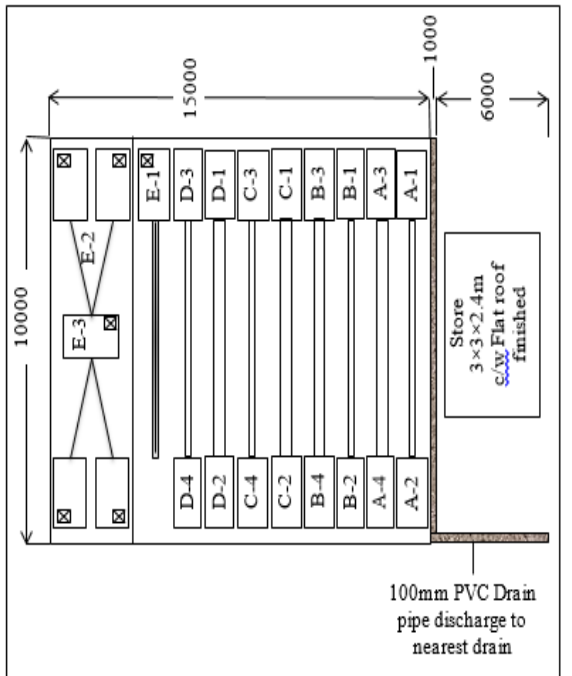
Figure 3 . Plan view of the test base